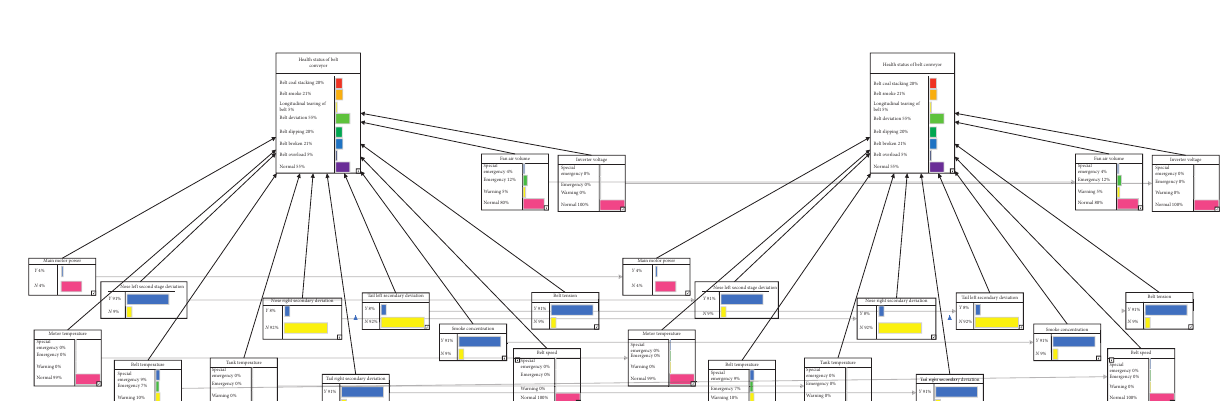
Figure 6: DBN prediction and performance evaluation results of belt